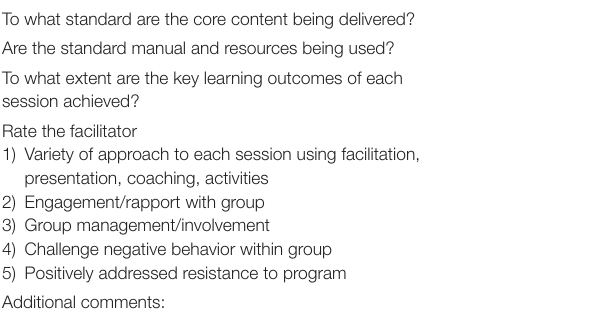
TABLE 4 | Observation checklist of PFA training